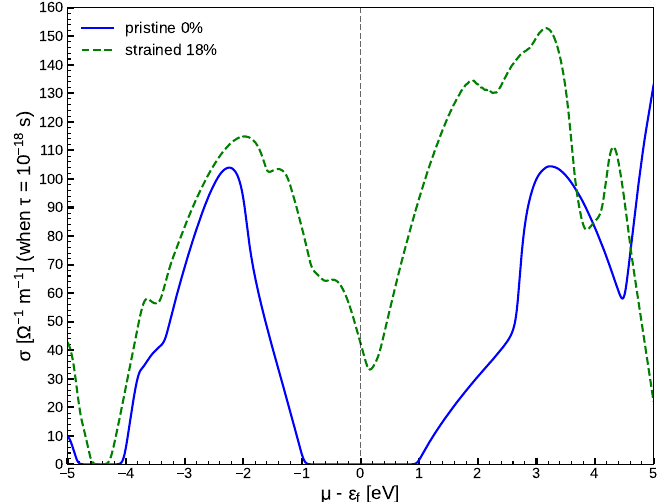
Figure 7. Calculated electrical conductivity of pristine (0%) and strained (18%) structures at ambient temperature. The electrical conductivity was calculated with respect to the relaxation time τ . The transporting directions are not distinguished